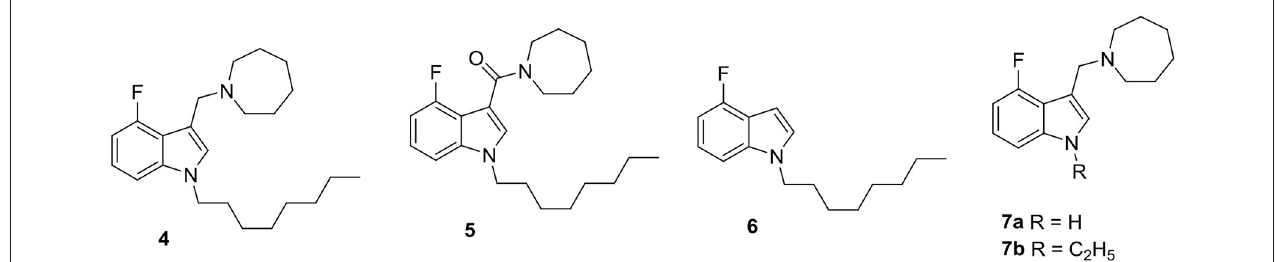
FIGURE 5 | The cationic amphiphilic indolyl Mannich base 4 is a membrane targeting mycobactericidal agent. Cationic amphiphilicity is absent in 5, 6, 7a, and 7b which are deconstructed analogs of 4 . They have poor antimycobacterial activities.